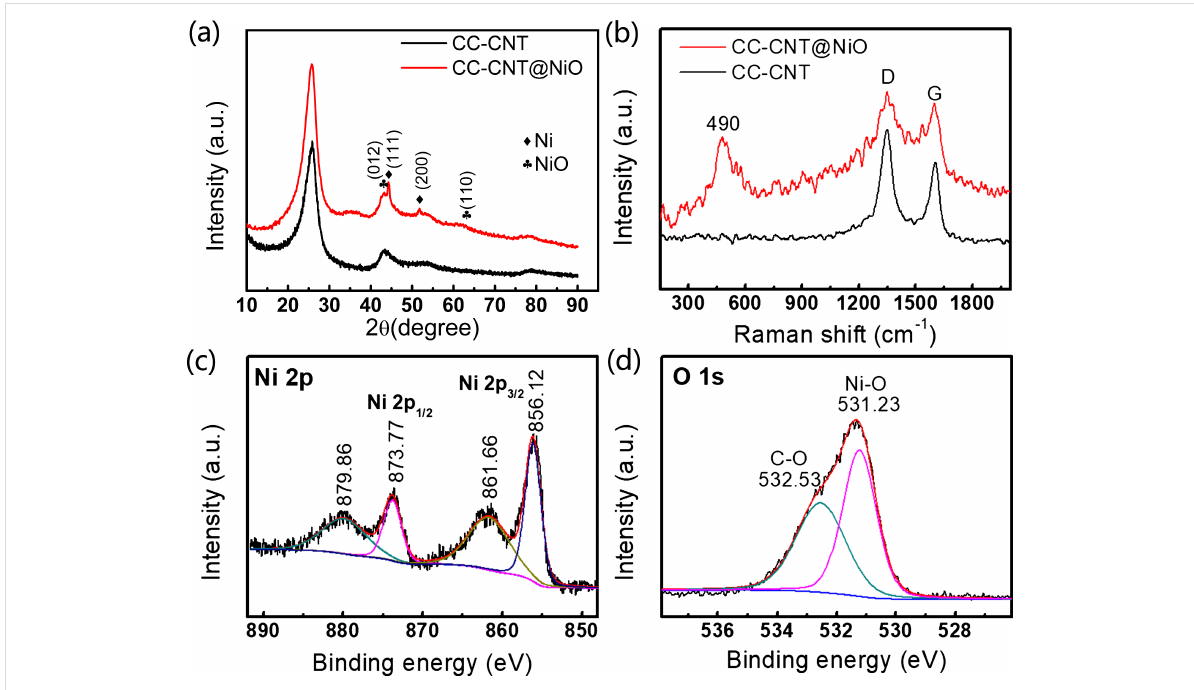
Figure 6: Characterization of CC-CNT@NiO: (a) XRD; (b) Raman; (c) Ni 2p and (d) O 1s XPS spectra.